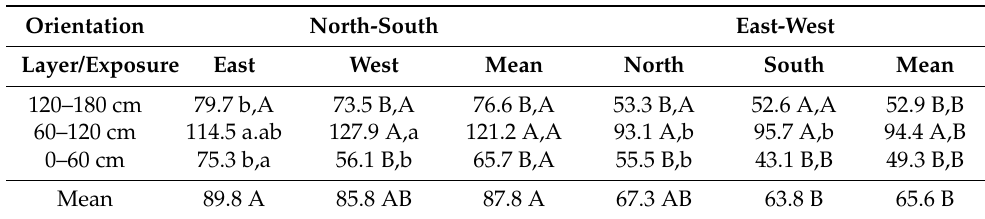
Table 7. Mean numbers of fruits per layer (FL). The first letters denote significant differences between layers for a given exposure; the second letters denote significant differences between exposures for a given layer (SNK test). Lower case letters denote statistical differences with p = 0.05. Capital letters denote statistical differences with p =